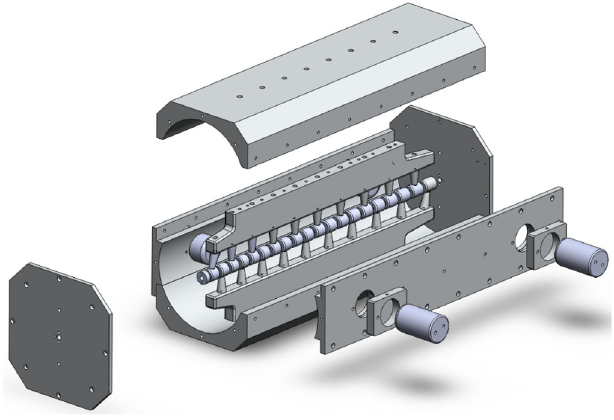
FIG. 23. Calculated and measured cell gradients in the IH1m tank cold model (left vertical axis) and differences between them (right vertical